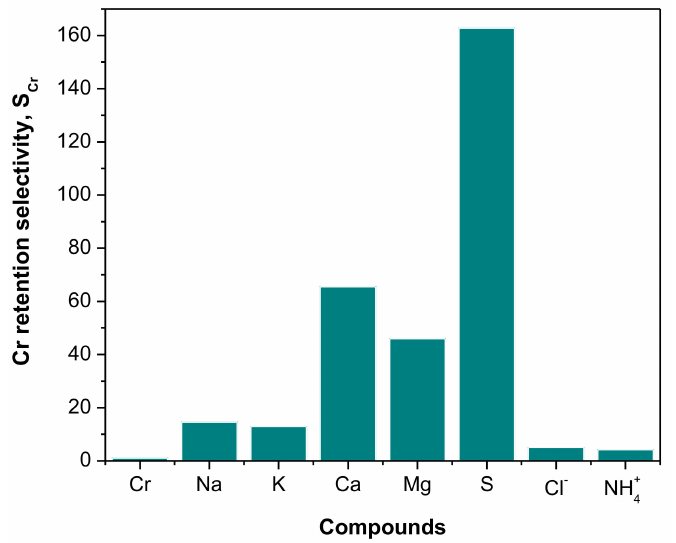
Figure 10. Selective retention of Cr(III) in the cs-PES MF022 membrane during the diafiltration of the SW30 concentrate of a real tannery effluent at 20